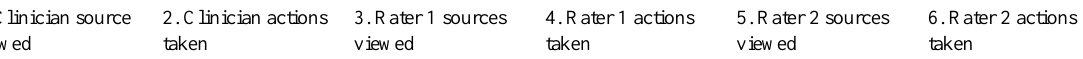
Table 3. Correlation matrix of study variables with significance level. a